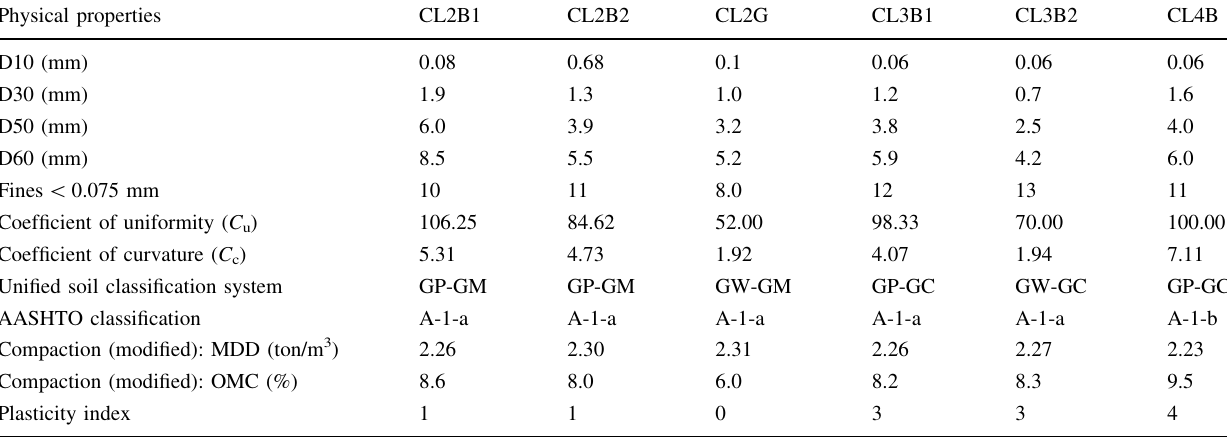
Table 3 Physical and geotechnical properties of the tested materials Physical